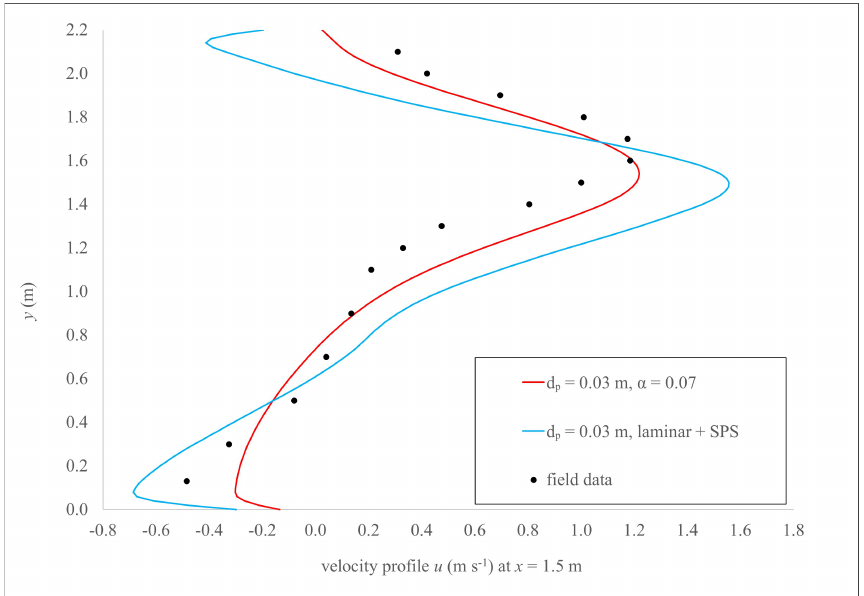
Figure 12. Average velocity profiles with artificial and laminar + SPS treatment of viscosity, both compared against field